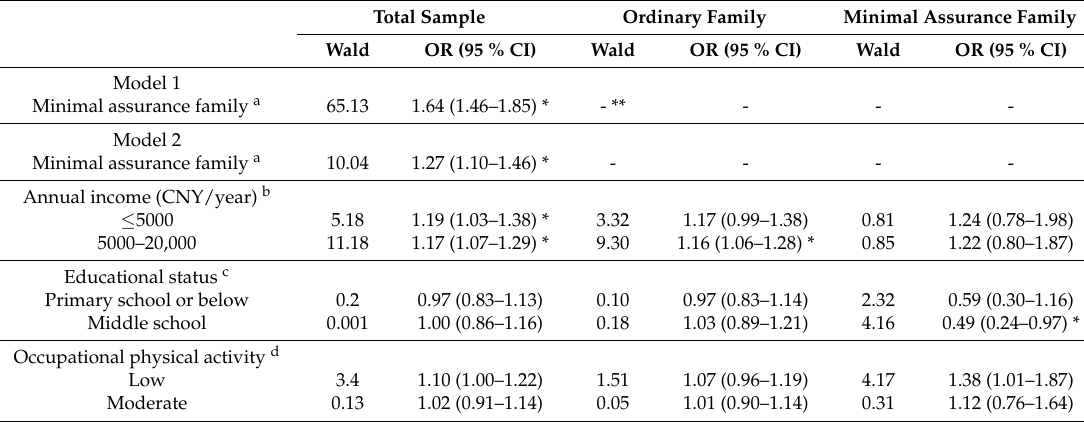
Table 3. Multiple regression analyses of hypertension and socioeconomic